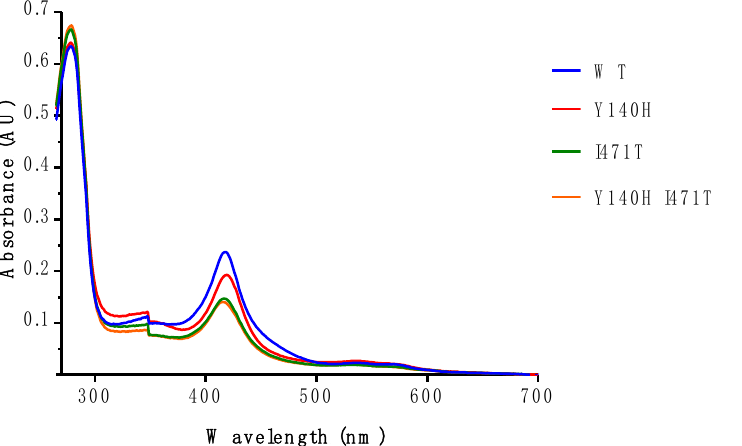
Figure 4. The absolute absorbance spectrum of apo-ScLDM6 × His is modified by the Y140H, I471T, and Y140H I471T mutations.